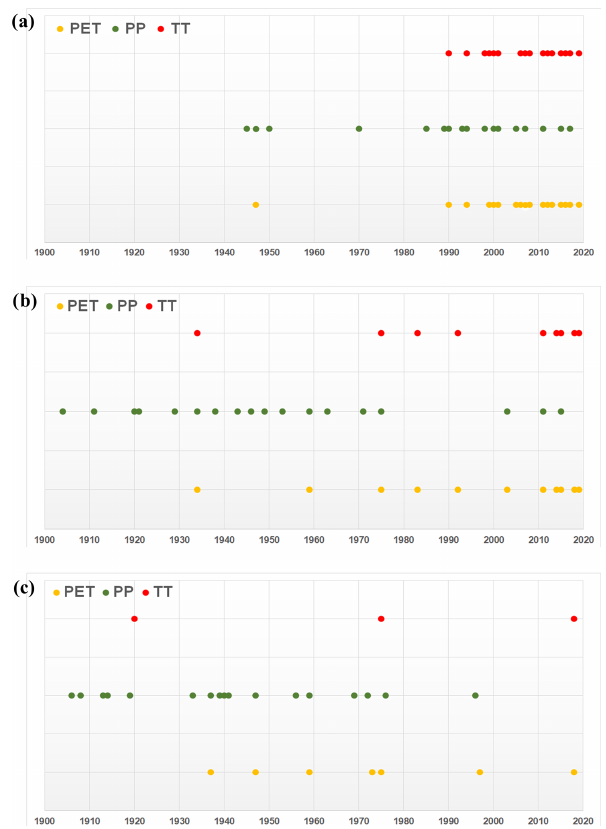
Figure 8. (a) Occurrence of warm and dry events (TT 80 /SPEI12 20 ; red dots), low precipitation and dry events (PP 20 /SPEI12 20 ; green dots), and enhanced evaporation and dry events (PET 80 /SPEI12 20 ; yellow dots) for the MED area. (b) As in (a) but for CEU and (c) as in (a) but for NEU. TT 80 /SPEI12 20 indicates that we took into account the common years when the temperature was higher than the 80th percentile and the SPEI12 was smaller that the 20th percentile. PP 20 /SPEI12 20 indicates that we took into account the common years when the precipitation was smaller than the 20th percentile and the SPEI12 was smaller that the 20th percentile. PET 80 /SPEI12 20 indicates that we took into account the common years when the potential evapotranspiration was higher than the 80th percentile and the SPEI12 was smaller that the 20th